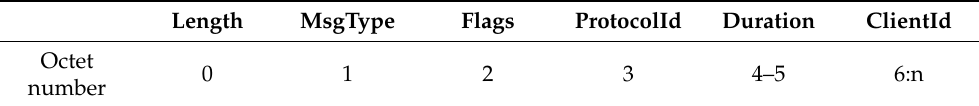
Table 2. Connect message